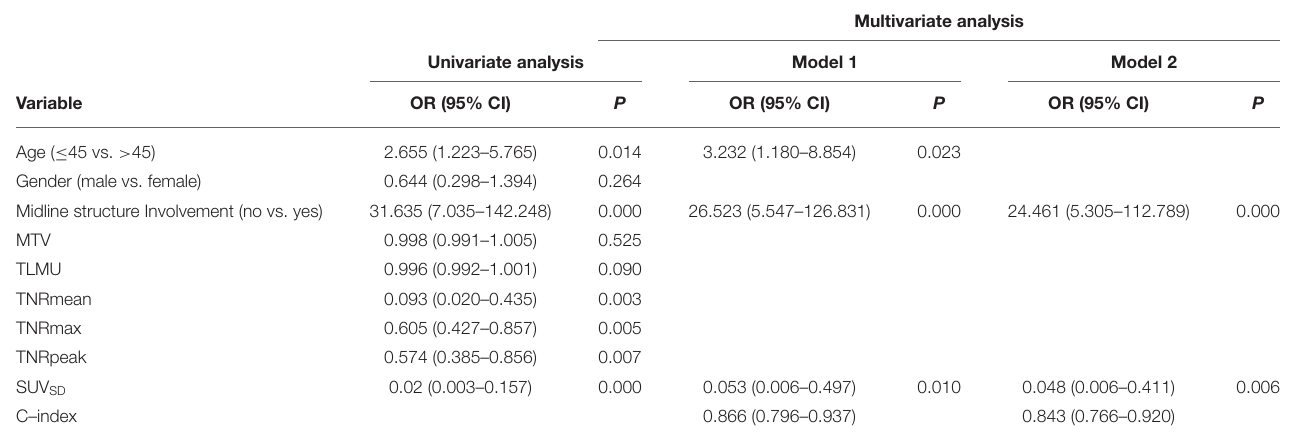
TABLE 5 | Univariate and multivariate regression analyses for IDH mutation